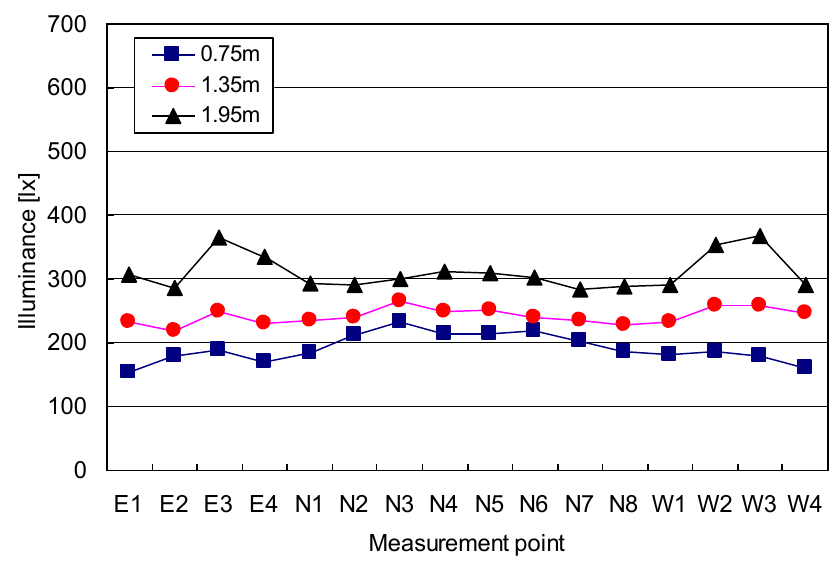
Figure 5. Variation of illuminance on walls (500 lx condition).